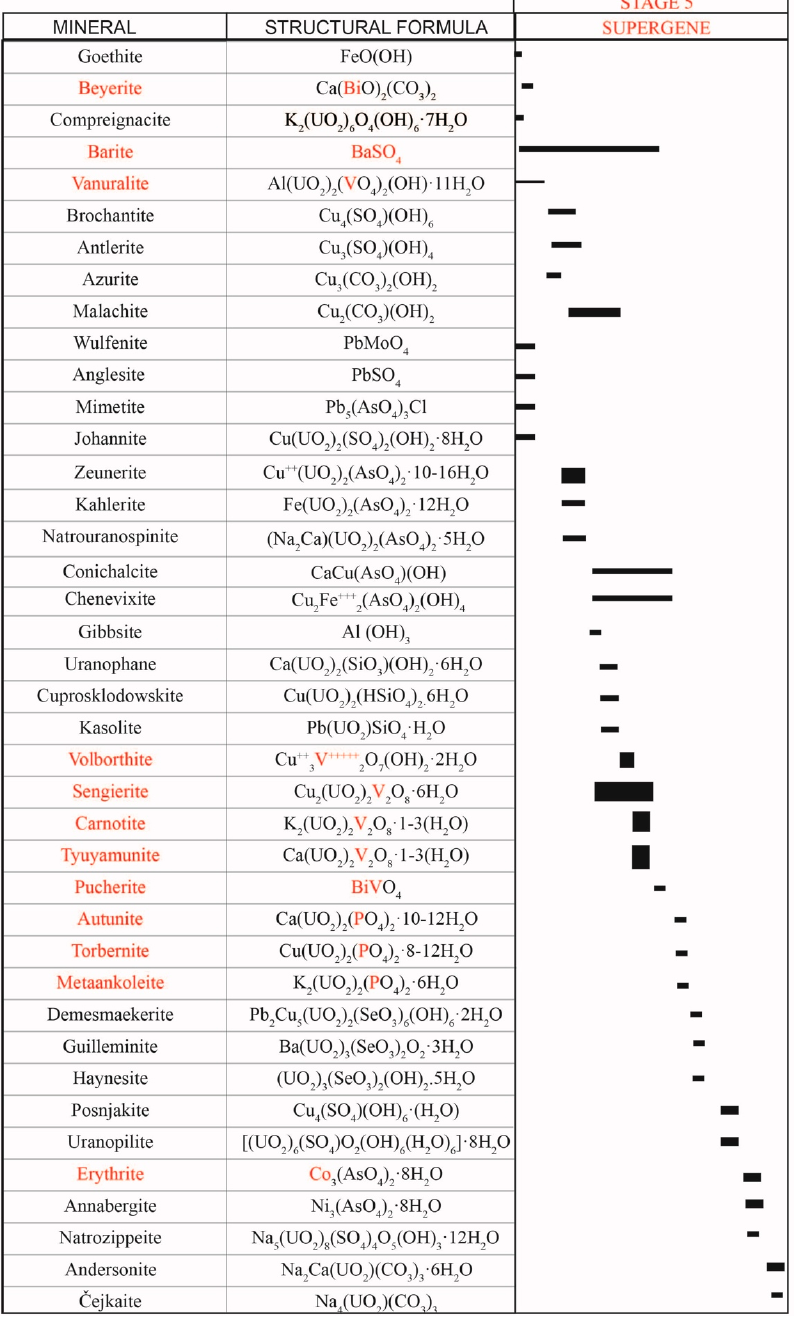
Figure 14. Crystallization sequence of the secondary minerals of the Eureka mine, indicating the minerals of critical elements [22] in red. Width of the lines are proportional to the modal abundance of the mineral in the deposit.